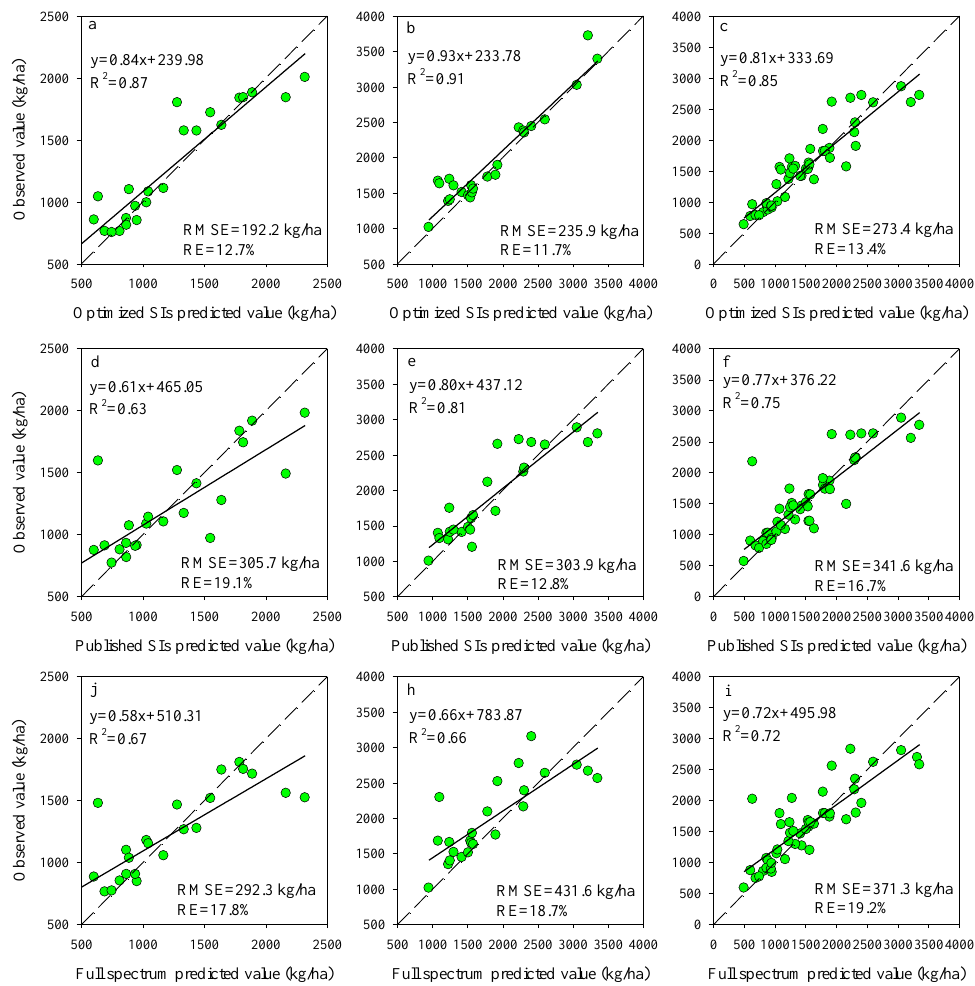
Figure 5. The relationships between the predicted value and observed value for different spectral variables of RF model at tuber formation ( a , d , j ), tuber bulking ( b , e , h ), and combined stage ( c , f , i ).